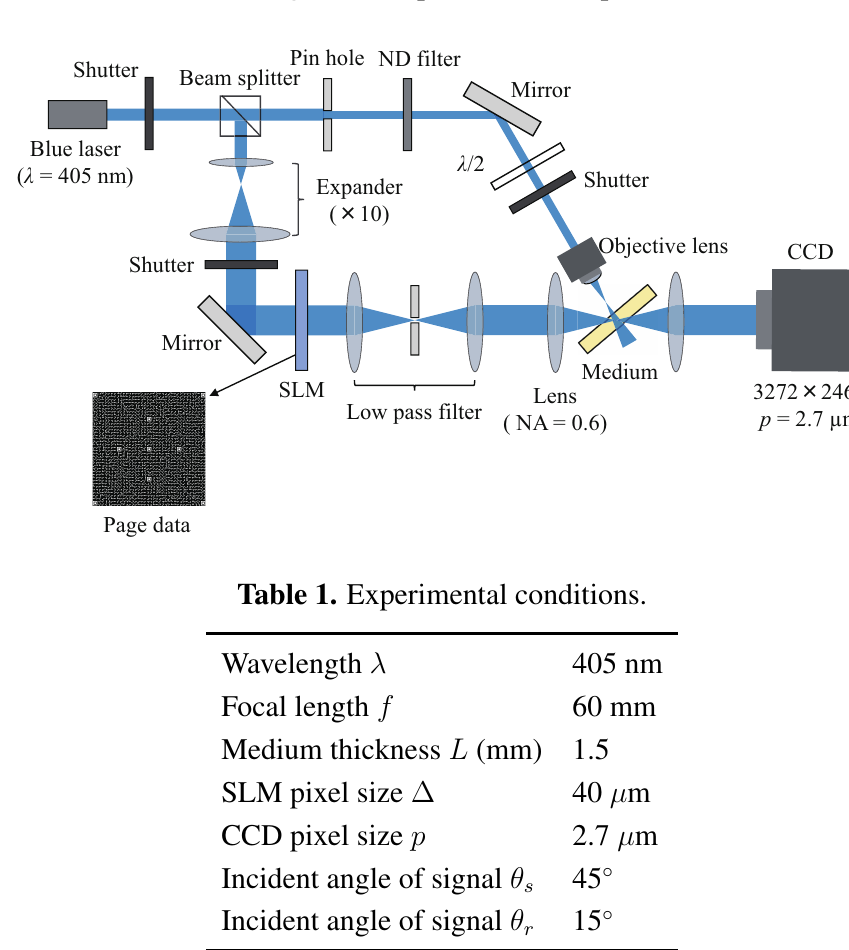
Figure 5. Experimental setup.